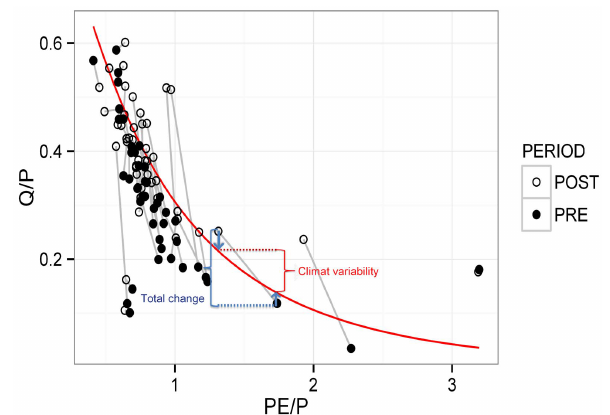
Figure 2. Budyko curve to quantify direct residual and climate im- pact on the flow change. Each site is described by Q , P and EP of pre and post-urbanization.